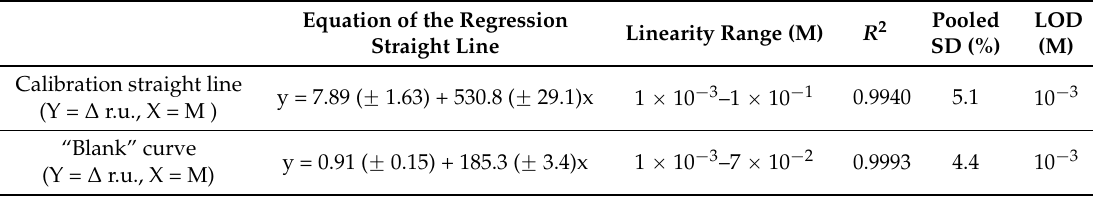
Table 1. Analytical data using an SPR device of both calibration and blank